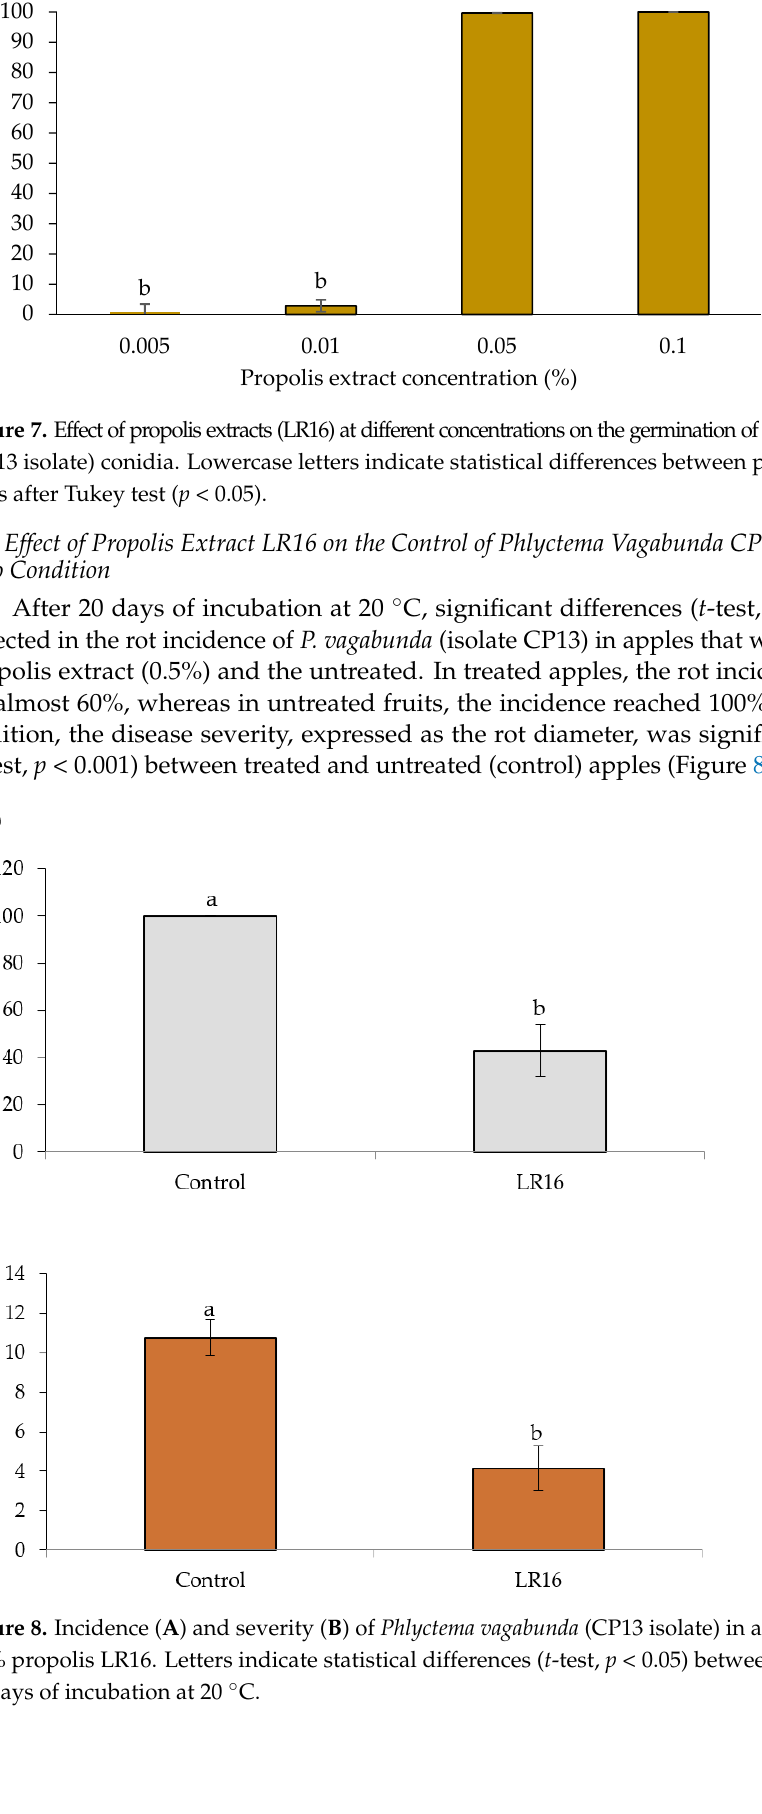
Figure 6. Effect of propolis extracts LR16 at 0% ( A ), 0.005% ( B ), 0.01% ( C ), 0.05% ( D ), and 0.1% ( E ) on the germination of Phlyctema vagabunda (CP13 isolate) conidia. The cultures were incubated at 20 °C for 4 days.